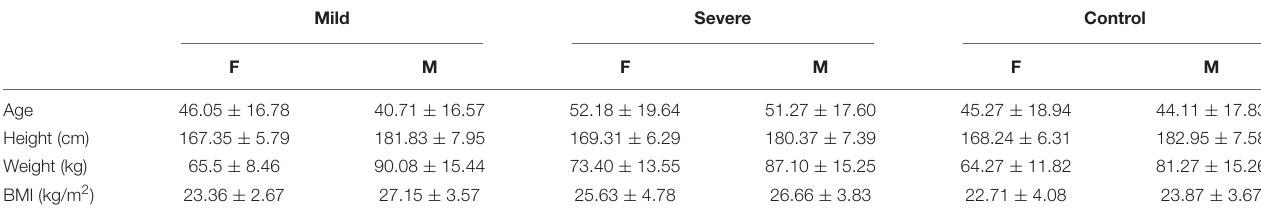
TABLE 1 | Population characteristics of COVID-19 patients and controls. Mild Severe